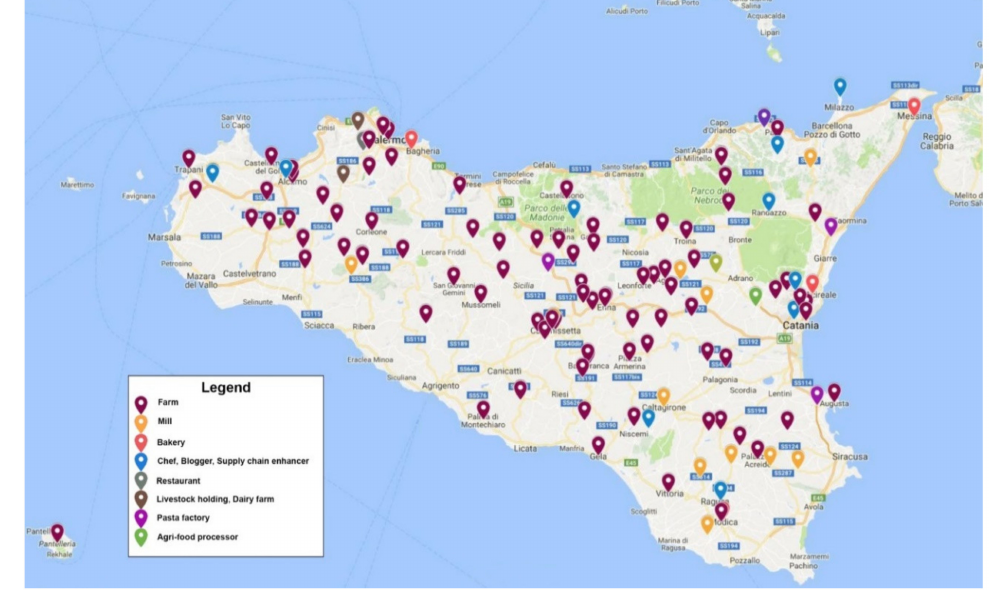
Figure 1. Map of Simenza members (2020). Table 2. Number of observations per year.